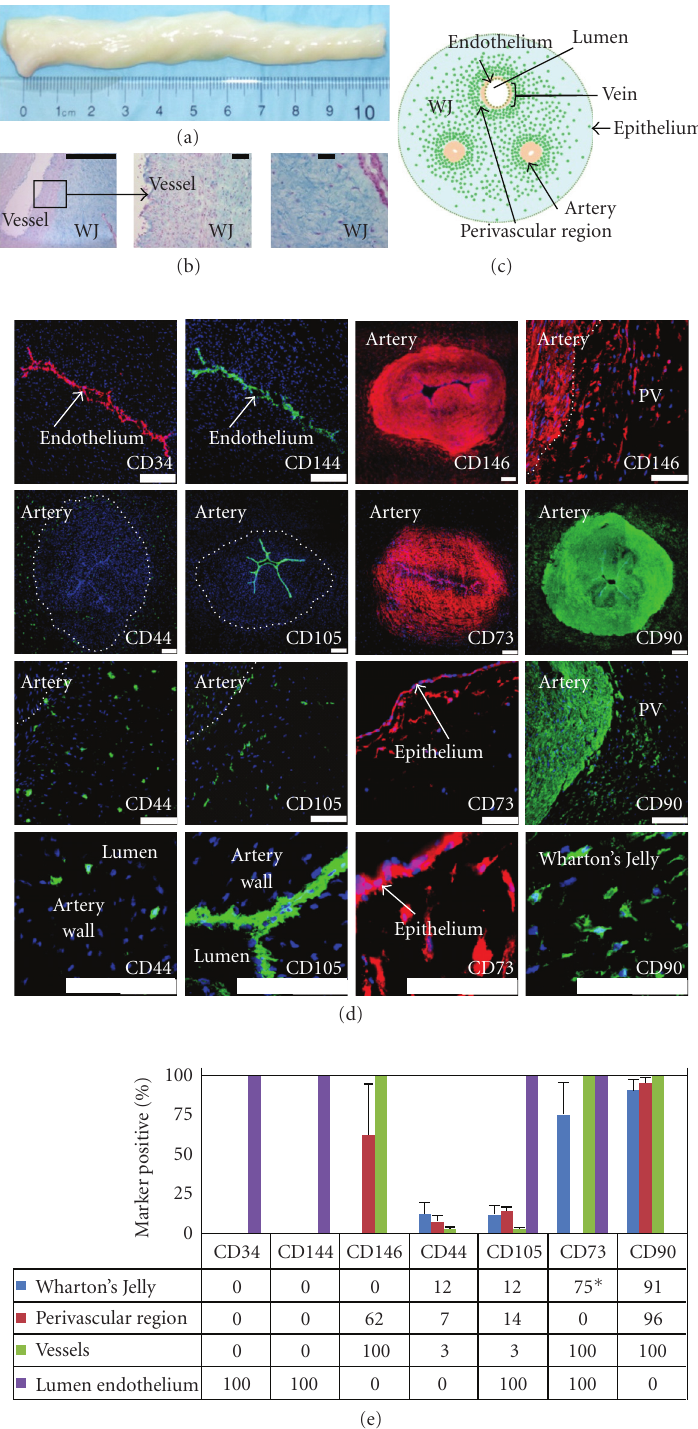
Figure 1: In situ examination of human umbilical cords. (a) UCs range in length up to 60 cm; shown is a cut 10 cm portion with UC blood removed. (b) Histology of 10micron thick cryosections stained with Alcian blue. (c) Schematic of UC cross-section. Green dots represent cells; all other structures are as indicated. (d) Detection of CD34, CD144, CD146, CD44, CD105, CD73, and CD90. CD34 and CD144 are expressed only in the endothelial lumen of the UC vessels. CD146 expression is present in both the vascular and perivascular regions, but not in the bulk of the WJ. CD44- and CD105-positive cells are found in the WJ, perivascular region, and in the vessels. CD105 is also in the lumen. A low level of CD73 expression is found throughout the vessels and high in the region just beneath the epithelium ( ∗ 75% positivity only in the region just below epithelium). CD90 positivity was detected in all regions, except the endothelium. Scale bars on whole vessel images represent 200 μ m; all others represent 100 μ m. (e) The percentage of cells expressing these markers was determined by immunostaining: (PV: perivascular